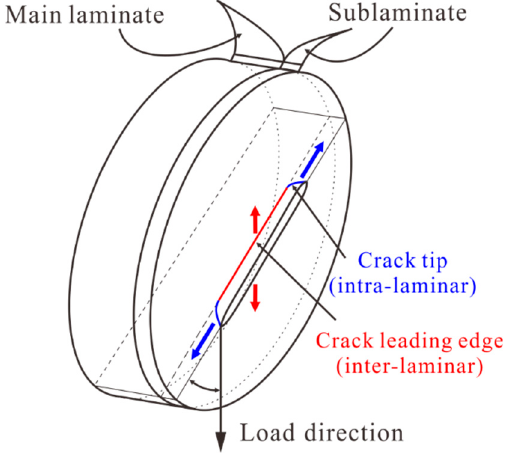
Figure 1. The schematic diagram of the surface crack.